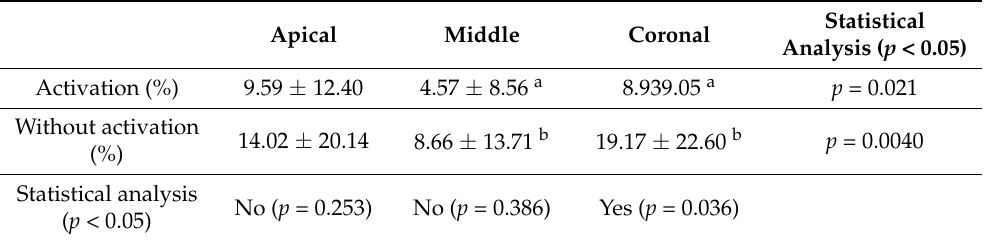
Table 1. Residual material percentages after both retreatment techniques with or without activation of endodontic irrigants. Different superscripted letters indicate significant differences between the different groups ( p < 0.05).